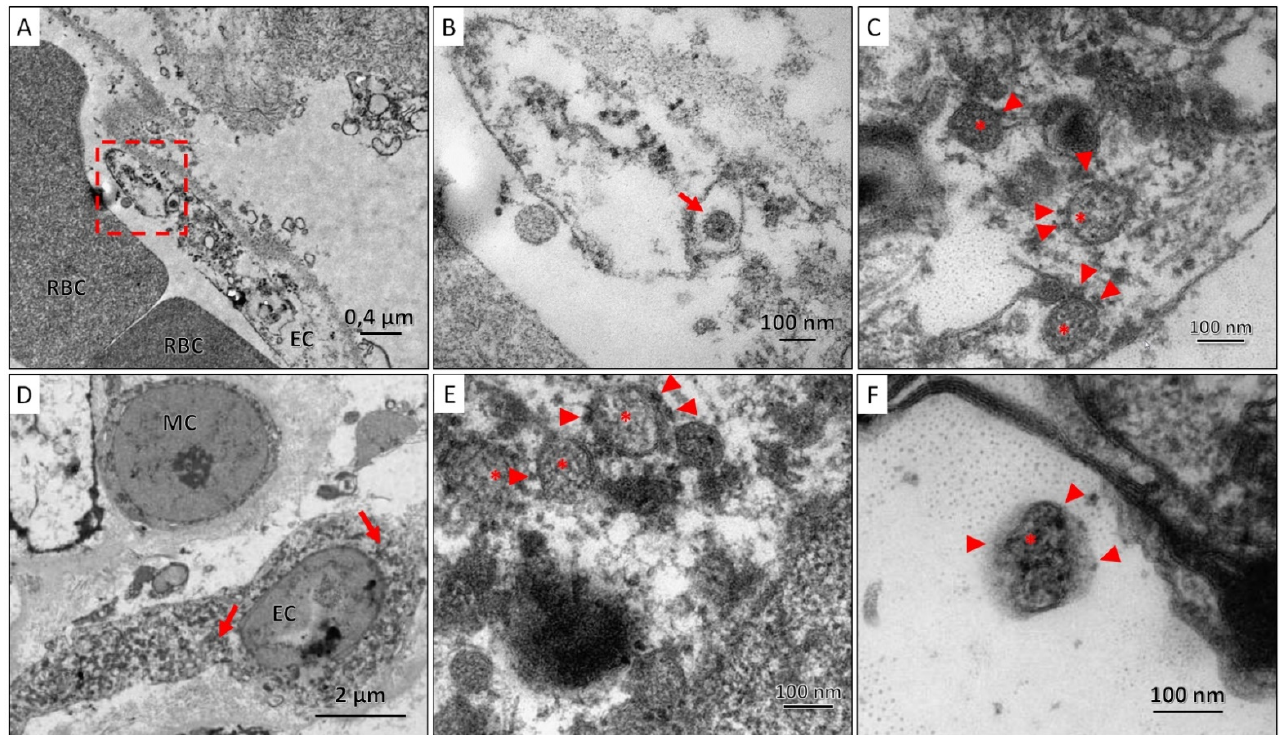
Figure 6. ( A ). Section of the air-blood barrier in which part of the endothelial cell (EC) and red blood cells (RBC) can be distinguished; SARS-CoV-2 virions were found in the cytoplasm of endothelial cells (red frame); ( B ). A coronavirus particle (red arrow) was found in the cytoplasm of the endothelial cell; ( C ). At high magnification, SARS-CoV-2 virions were characterized by a spherical shape, with an average size of 100 nm, surrounded by a membrane, on the surface of which there are electron-dense outgrowths of the S-protein (arrowhead), and granular nucleocapsid structures (asterisks); ( D ). A region of the vascular glomerulus of the kidney with mesangial (MC) and endothelial (EC) cells, in the cytoplasm of which SARS-CoV-2 virions are found closer to the nucleus (red arrows). ( E , F ). At high magnification, SARS-CoV-2 virions were characterized by a spherical shape, with an average size of 100 nm, surrounded by a membrane, on the surface of which there are electron-dense outgrowths of the S-protein (arrowhead), and granular nucleocapsid structures (asterisks) can be seen in the lumen of the particles. Table 2. SARS-CoV-2 VL levels in heart, liver, and kidney, and serum biomarker levels of 27 COVID-19 patients.